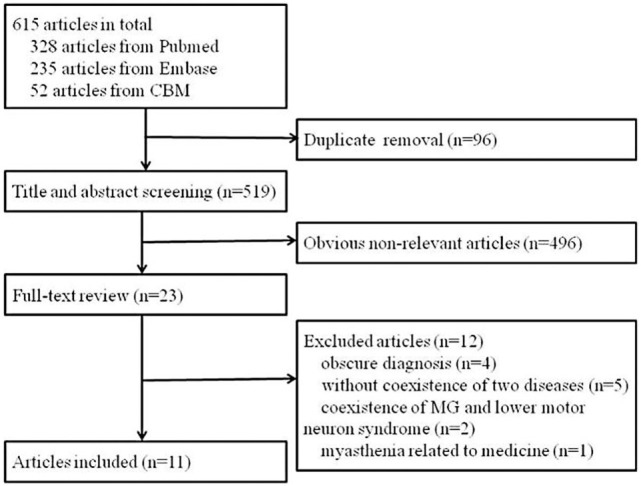
Flow chart of article retrieval.